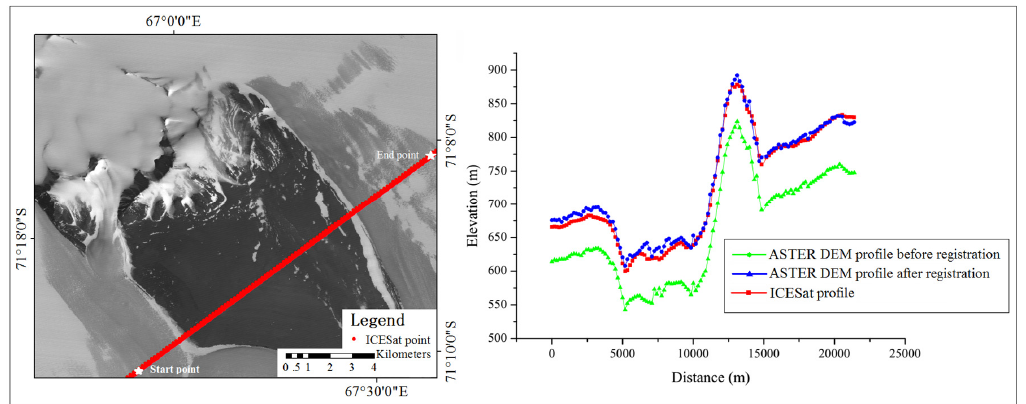
Figure 8. Profile comparison along an ICESat track between the ICESat data and the derived Digital Elevation Models (DEMs) from the ASTER images before and after registration.